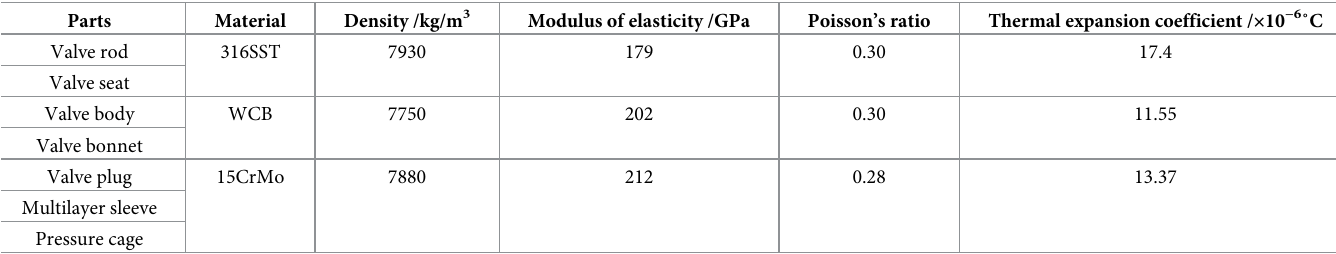
Table 4. Material parameters of the main